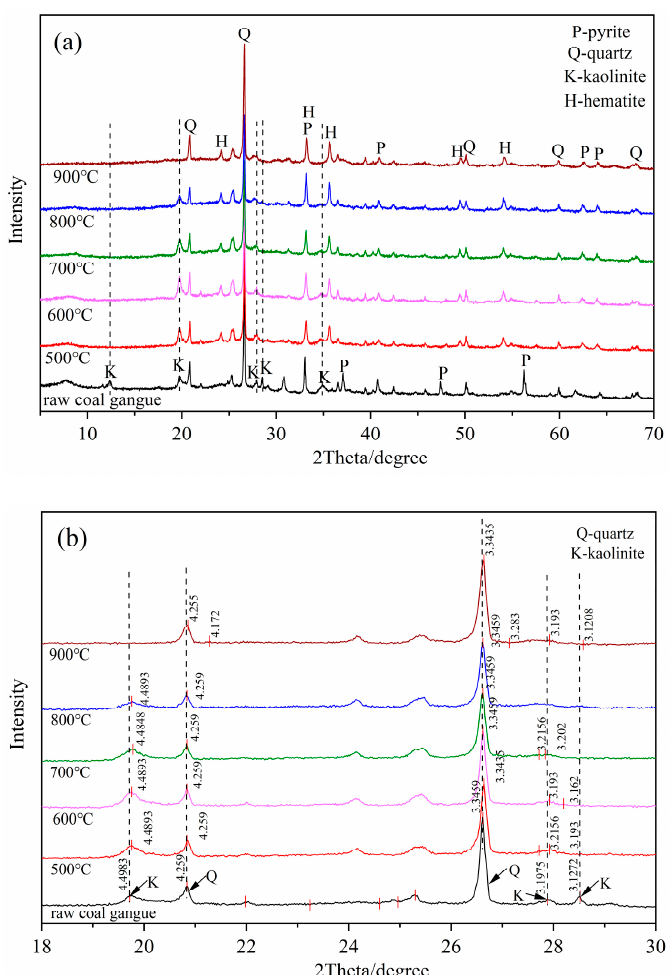
Figure 2. Mineralogy characteristics of the raw and calcined CG samples at different calcination temperatures ( a ) Crystal diffraction peak after thermal activation, ( b ) Plane spacing